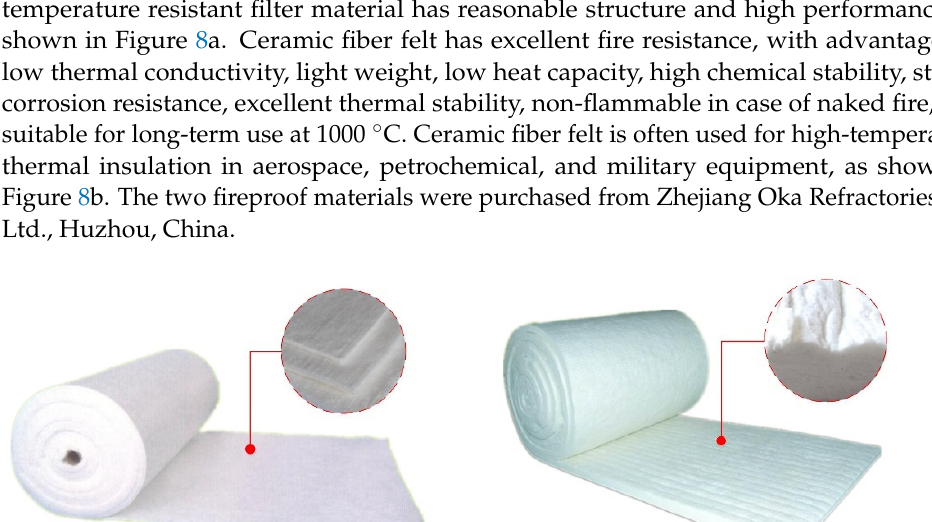
Table 3. Working conditions of test specimen.